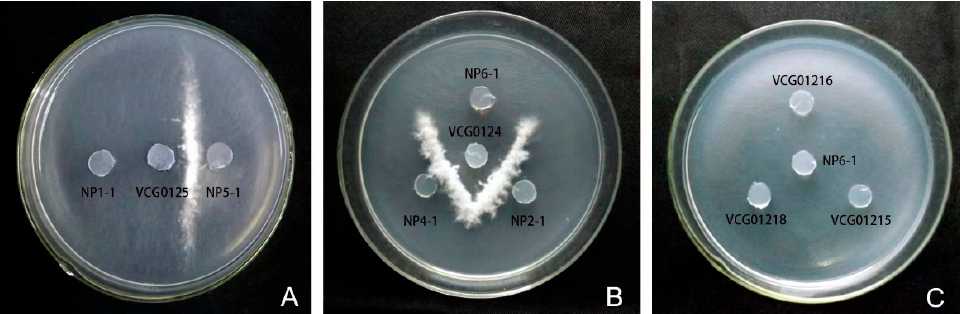
Figure 6. Compatibility assays between nit mutants on minimal medium (MM). ( A , B ) Heterokaryon formation when pairing the tester and some isolates; ( C ) no heterokaryon formation when pairing testers and isolate